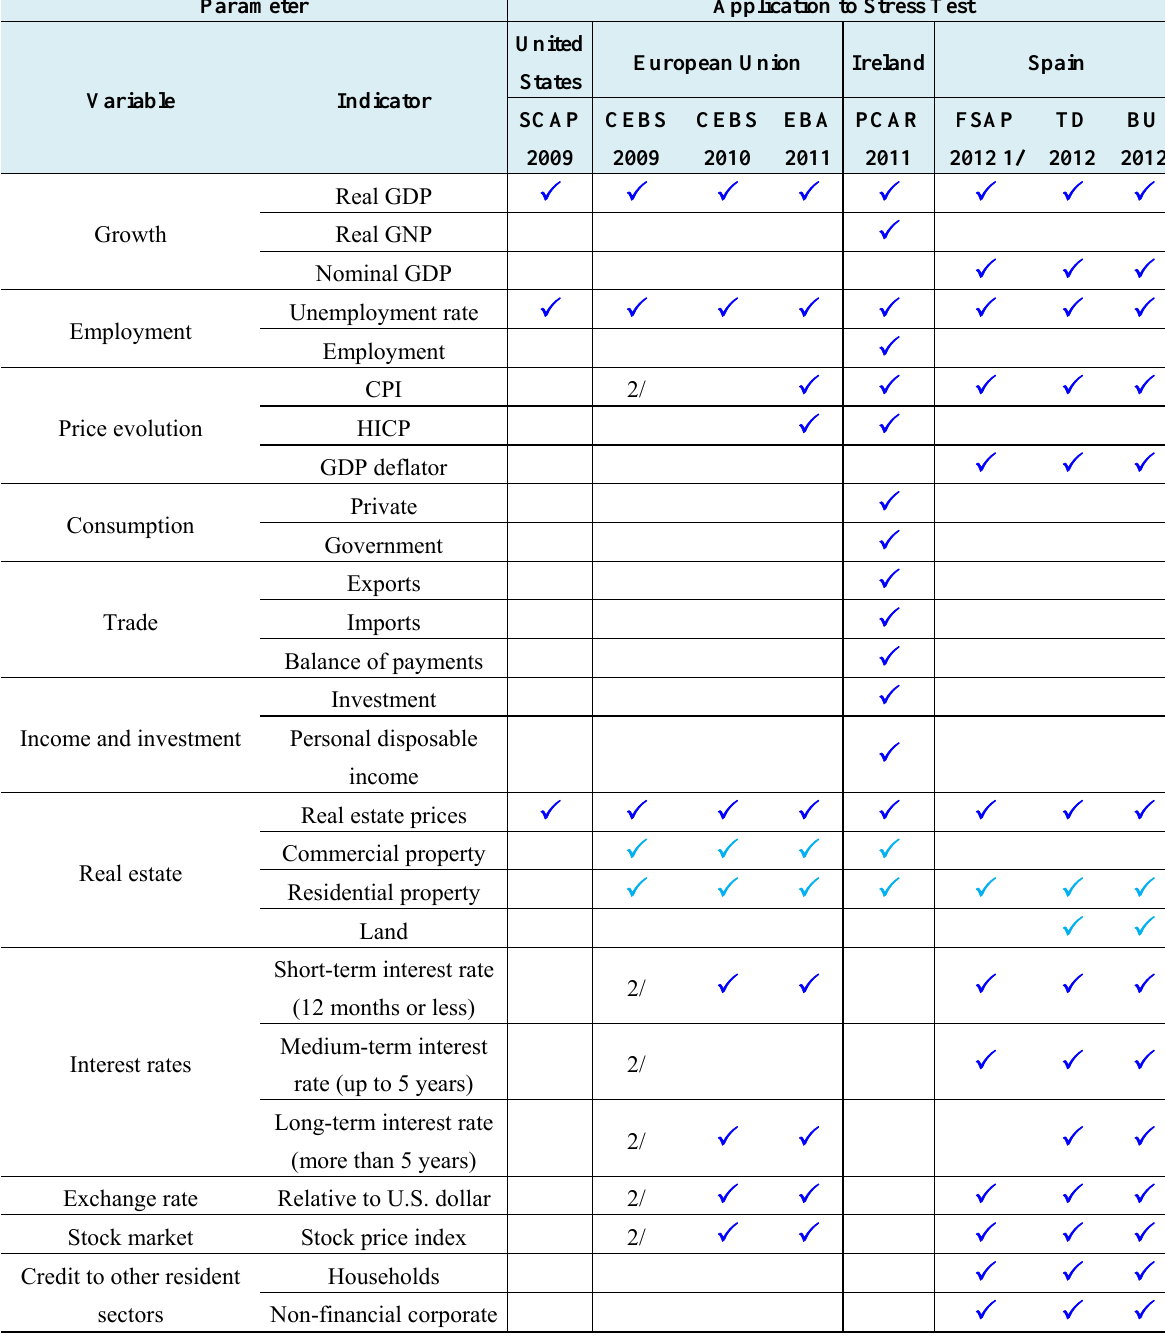
Table 7. Crisis Stress Tests: Macro-financial Parameters